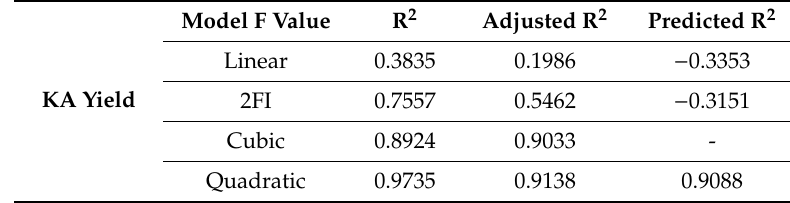
Table 7. Regression analysis results.